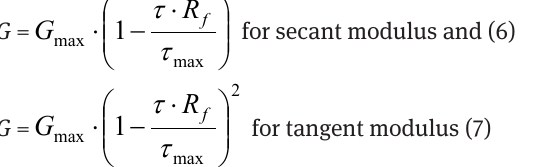
formula is verified on the basis of the results of laboratory tests using a triaxial apparatus, a resonant column (RC) or a torsional shear (TS) apparatus. Most of the above-mentioned shear modulus degradation functions were created on the basis of soil analysis studies in the RC. In the research, the dependence of the shape of the degradation curve was determined, among others, on the isotropic stress value and the plasticity index.